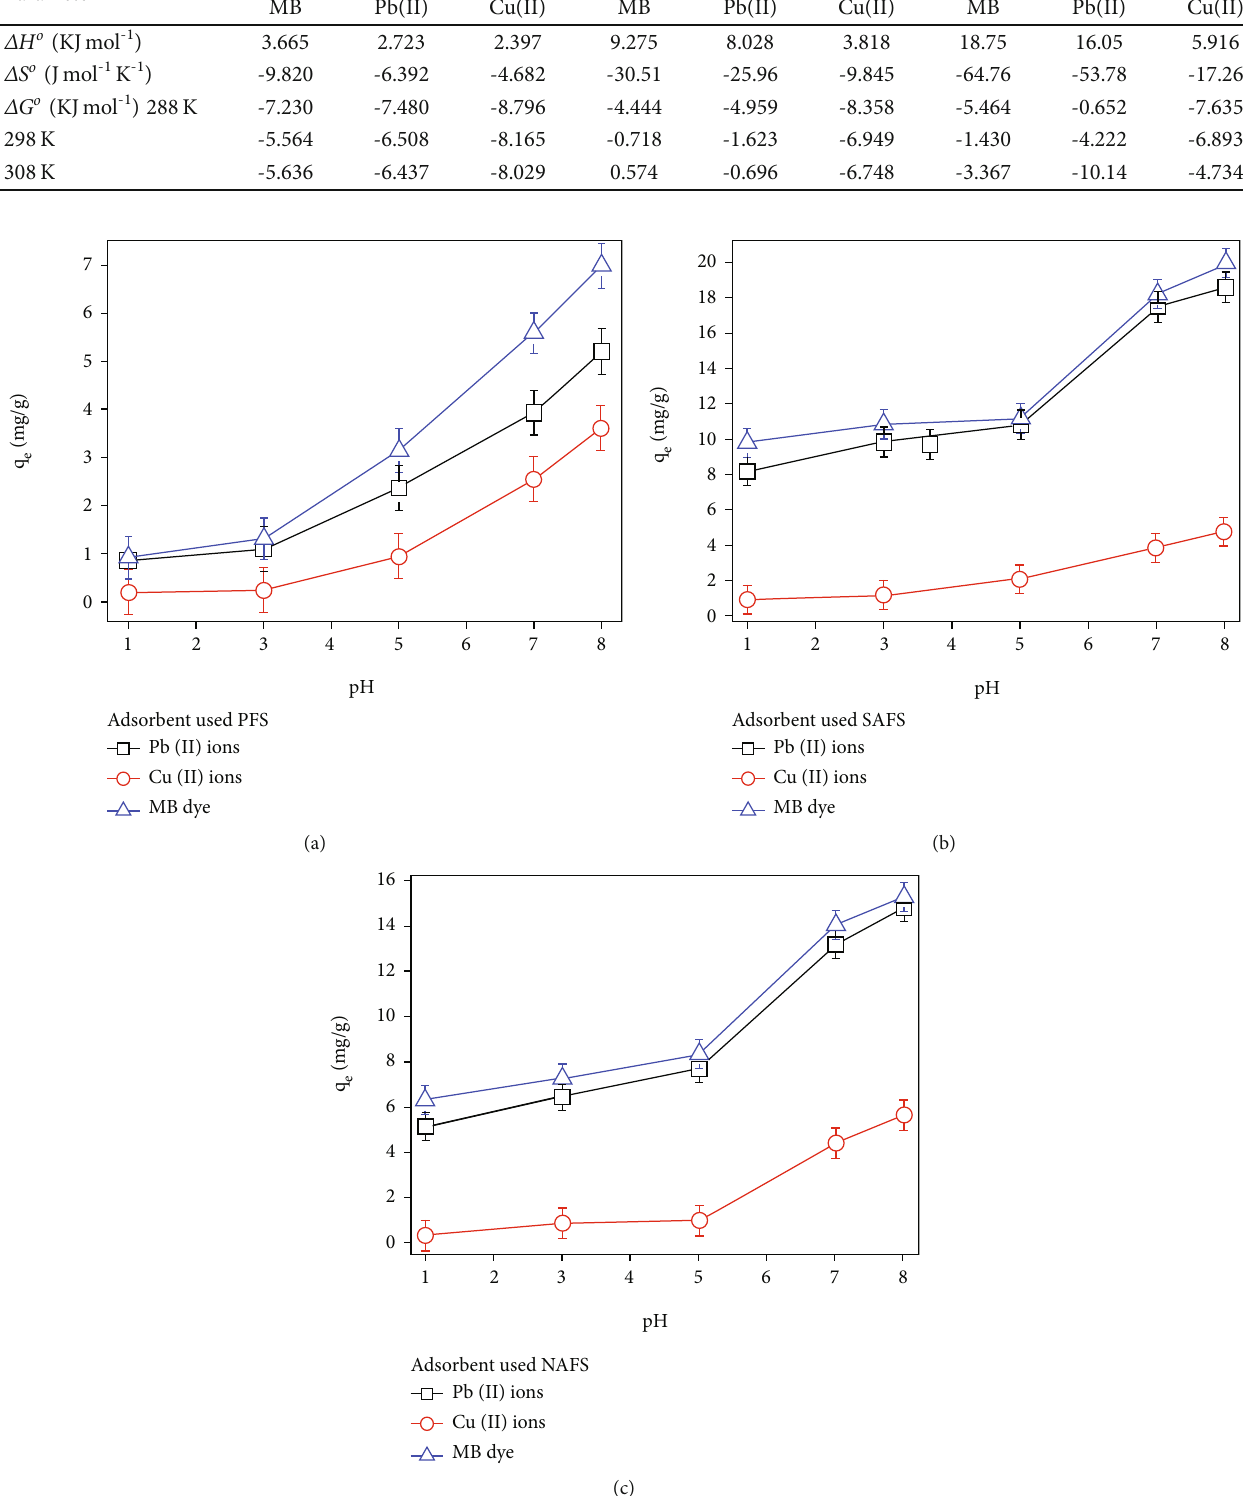
Figure 8: pH e ff ect on the removal of Pb(II), Cu(II), and MB onto pure (a) PFS and treated (b) SAFS and (c) NAFS fennel seed adsorbents (system parameters: temperature = 298K, working solution = 100mg/L, contacttime = 120 min, andadsorbent mass = 10mg